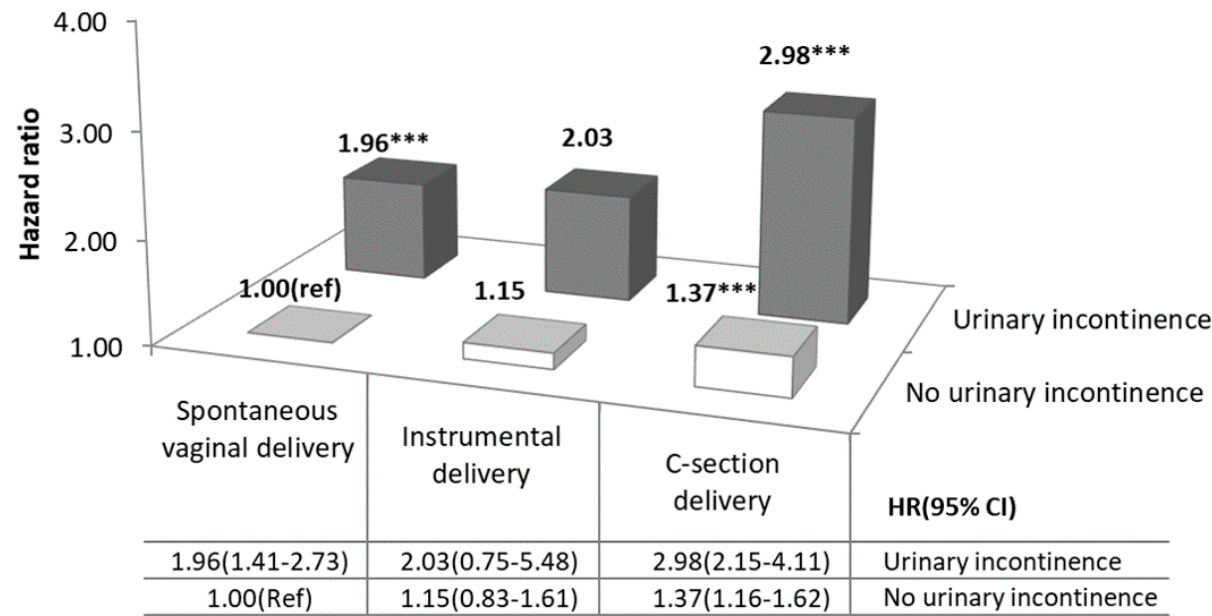
Figure 1. Combined effect of urinary incontinence and mode of delivery on postpartum depression within six months after childbirth. Adjusted for maternal age, income level, type of insurance, residential area, parity, twin birth status, maternal comorbidities, obstetric complications, and year. *** p < 0.001.